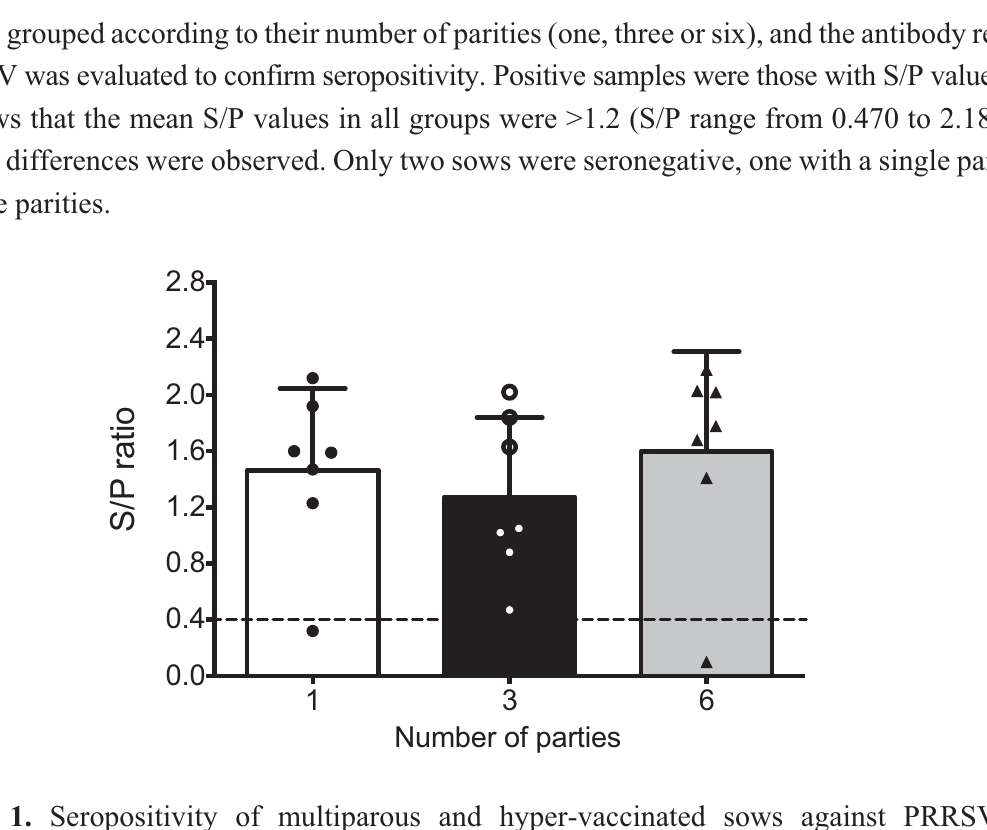
Figure 1. Seropositivity of multiparous and hyper-vaccinated sows against PRRSV. PRRSV-specific antibodies were detected in the sera of sows based on parity groups using IDEXX ELISAs ( n = 7 per group). The positive threshold was a sample to positive (s/p) ratio of 0.4, according to the manufacturer’s instructions. No statistical significance was observed between the groups in this assay. Each bar represents the S/P ratio mean of seven sows ± standard deviation. White, black and gray bars represent the groups of sows with one, three and six parities,